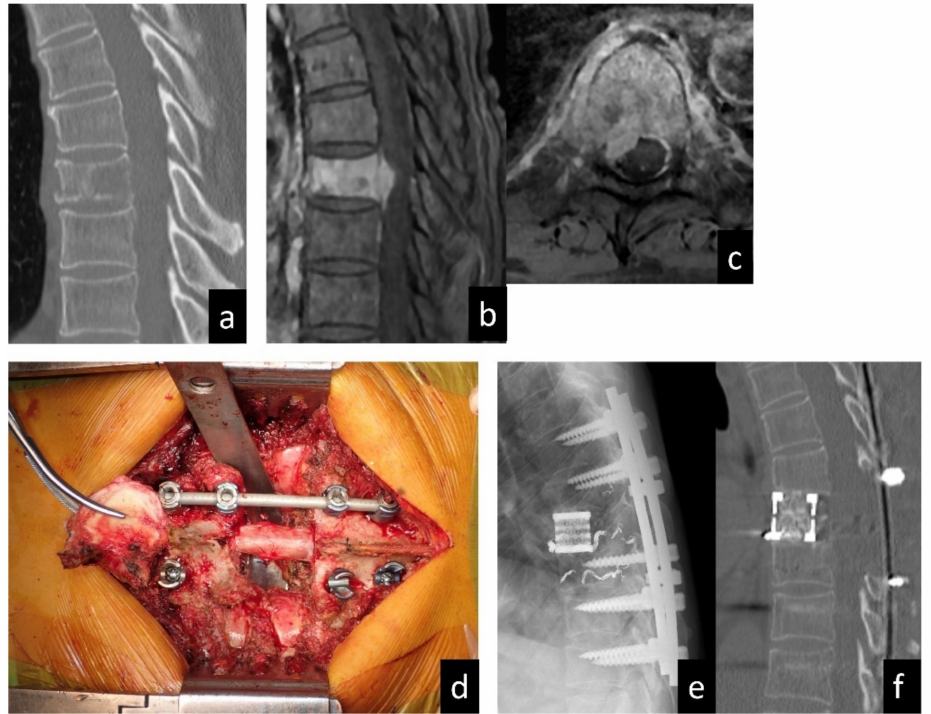
Figure 1. A 63-year-old man diagnosed with SM of T8 from renal cell carcinoma. ( a ) Sagittal plane computed tomography image showing the osteolytic lesion in the T8 vertebral body. ( b ) Sagittal and ( c ) axial images of enhanced T1-weighed magnetic resonance imaging showing spinal canal extension of the tumor. ( d ) Intraoperative photo in the resected vertebral body. ( e ) Radiograph in lateral view and ( f ) computed tomography in sagittal view showing the reconstructed spine after metastasectomy (total en bloc